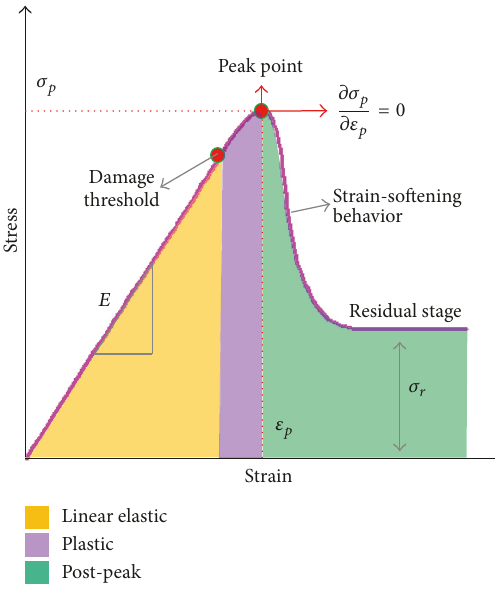
Figure 2: Typical stress-strain relationship. 𝜎 𝑝 is the peak/failure strength of materials, 𝜀 𝑝 the peak strain, and 𝜎 𝑟 the residual